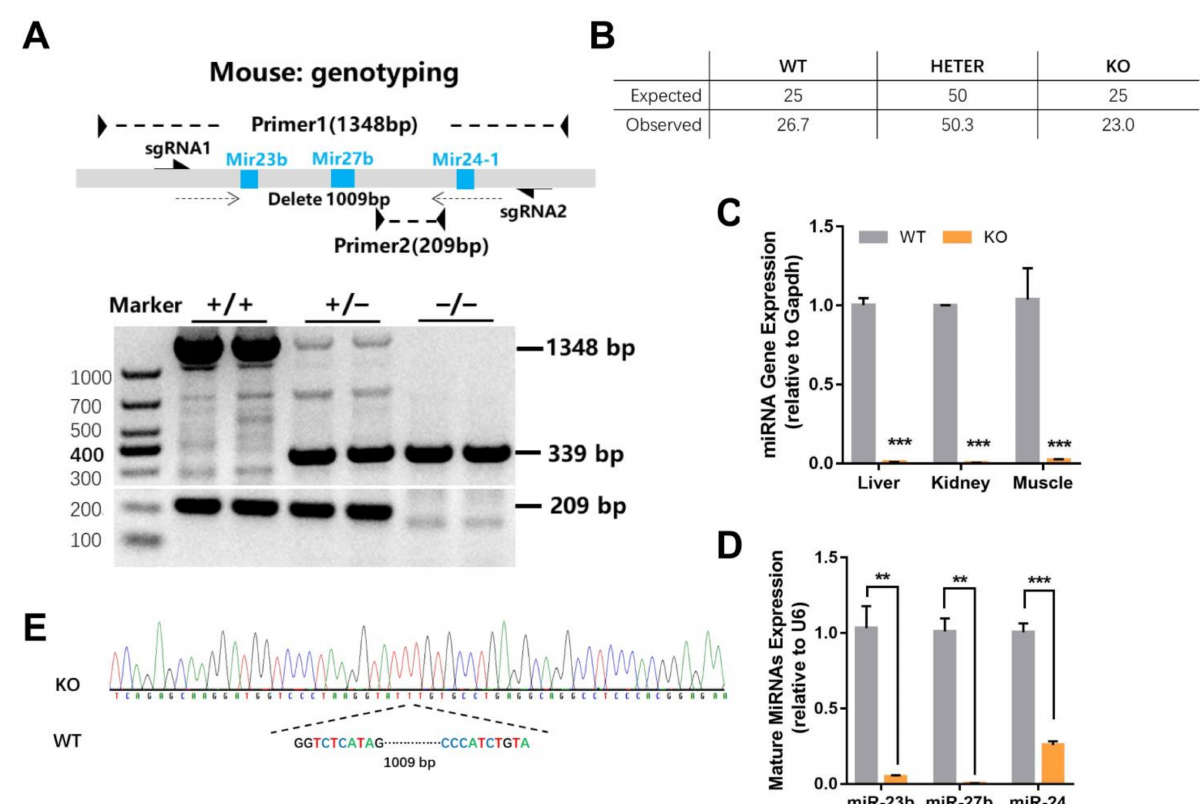
Figure 1. Generation of miR-23b/27b/24-1 cluster knockout mice. ( A ) The construction and genotyping of miR-23b/27b/24- 1 cluster knockout mice. ( B ) The proportion of offspring genotypes obtained by mating heterozygous mice ( n = 187). ( C ) The miRNA gene expression (relative to Gapdh ) of liver, kidney, and muscle between wild-type (WT) and knockout (KO) mice ( n = 3). ( D ) The expression of mature miRNAs expression (relative to U6 ) between the WT and KO mice ( n = 4). ( E ) DNA sequencing results between WT and KO mice. Data were represented as mean ± SEM. Significance was determined by Student’s t -test analysis, ** p < 0.01, *** p <